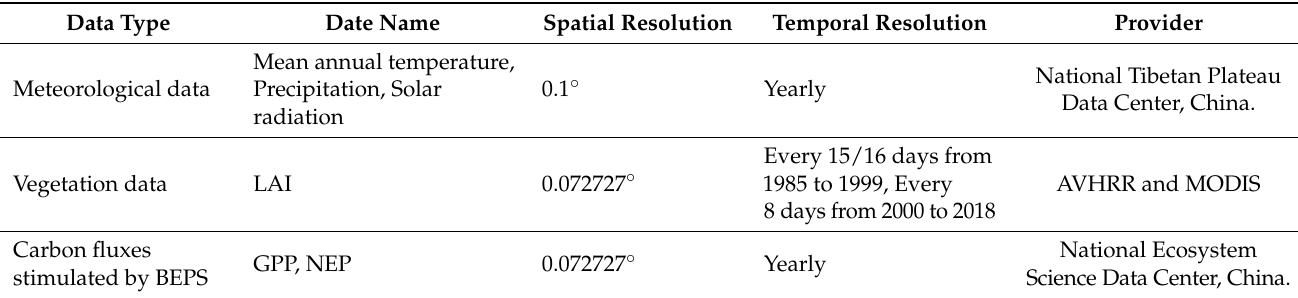
Table 1. Description of the data used in this study.